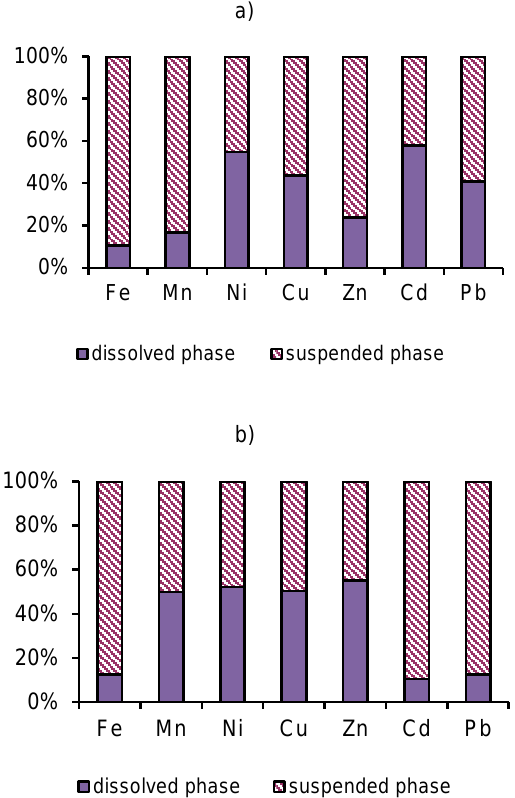
Figure 6. Variation of dissolved and suspended forms of migration heavy metals in the sampling sites M1( a ) and M2 ( b ).